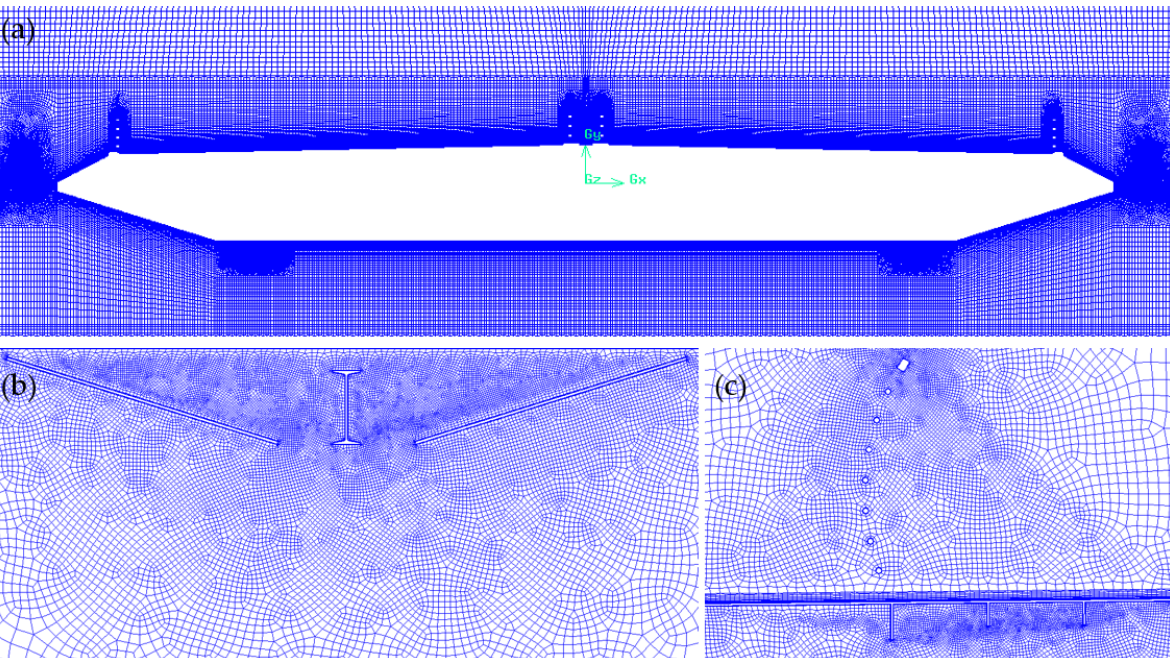
Figure 11. Girder cross-section of LDYB main span (unit: mm).